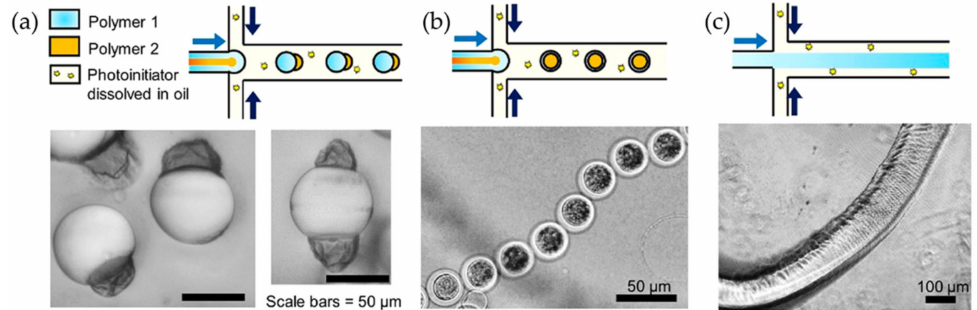
Figure 25. Wrinkled surface patterning formation on various microstructures created using a mi- crofluidic system. ( a ) Janus particles with wrinkled sides, ( b ) Wrinkled core-shell with inner core underneath another hydrogel layer, and ( c ) Wrinkled surfaced fibers. Reproduced with permission from reference [56]. Copyright 2021, American Chemical Society